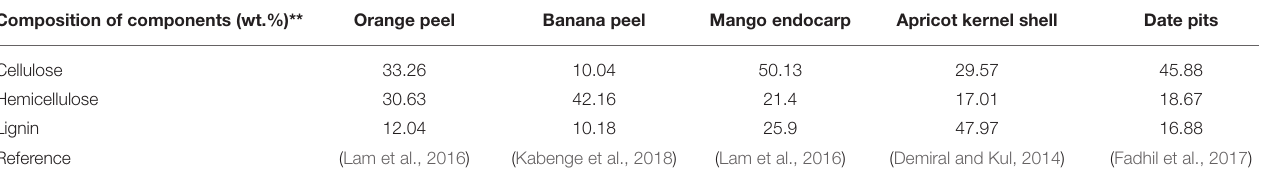
TABLE 2 | Chemical wet analysis results of the selected fruit wastes. Composition of components (wt.%)** Orange